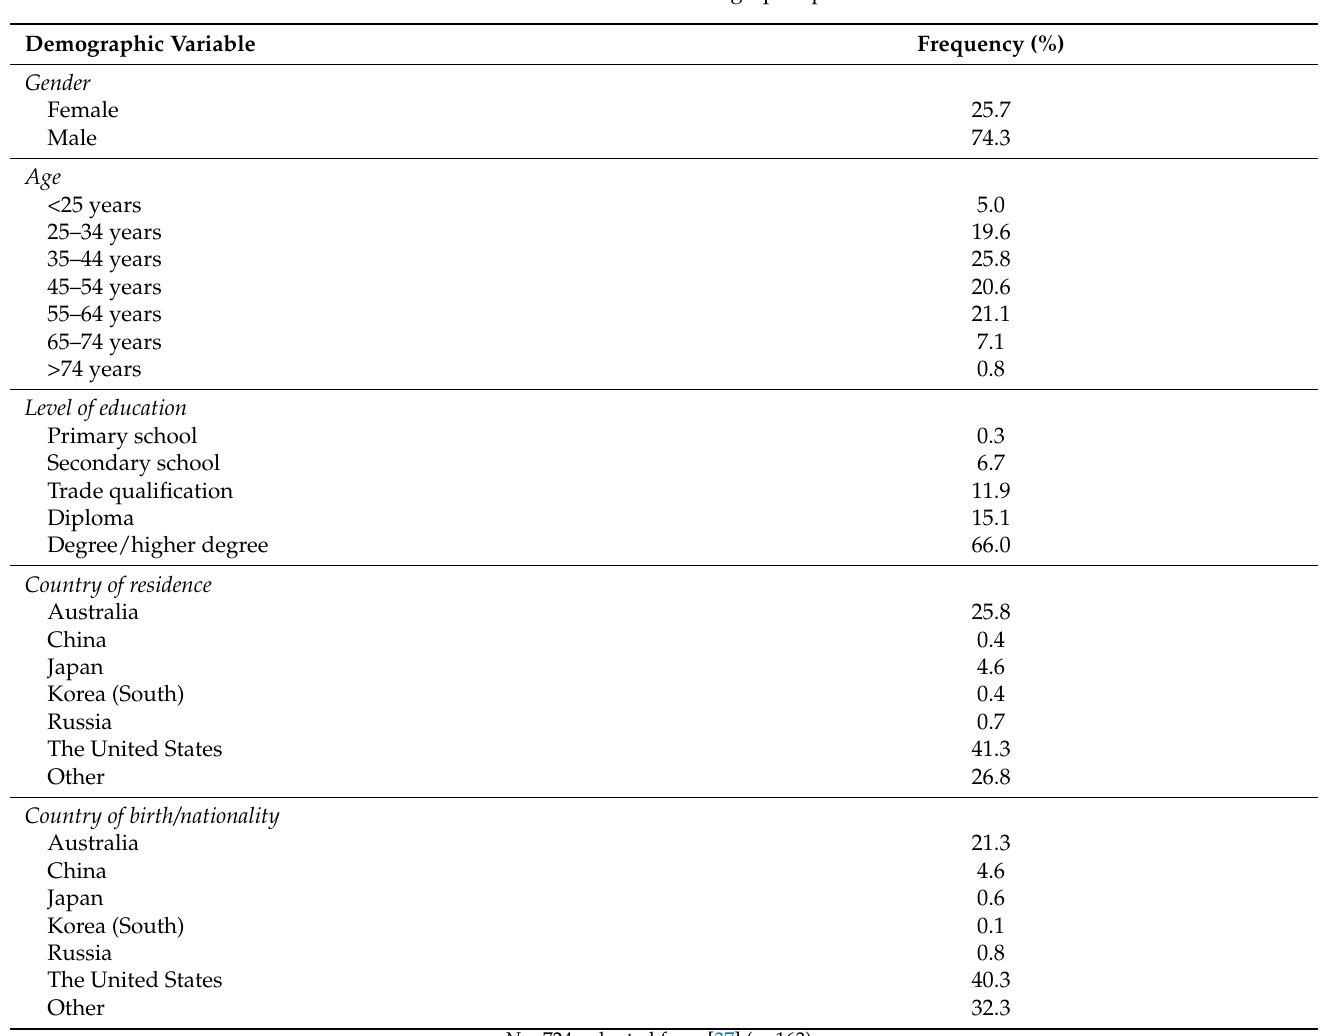
Table A2. Wreck diver demographic